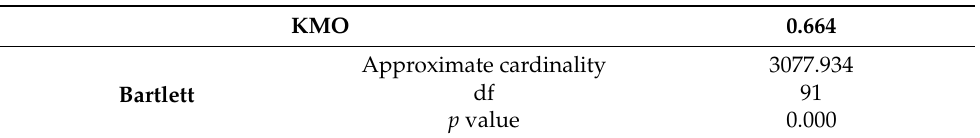
Table 4. KMO and Bartlett